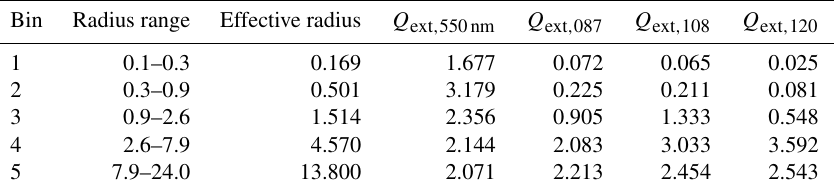
Table 1. Size ranges, effective radii (µm), extinction efficiencies at 550nm ( Q ext , 550nm , unitless), and IR extinction efficiencies (unitless) of the five COSMO-MUSCAT size bins. Extinction efficiencies at 550nm are derived for spherical particles from refractive indices developed by Sinyuk et al. (2003). IR extinction efficiencies ( Q ext , ch ) are calculated for spherical VO73 dust, convolved over the MSG-2 SEVIRI filter functions. Bin